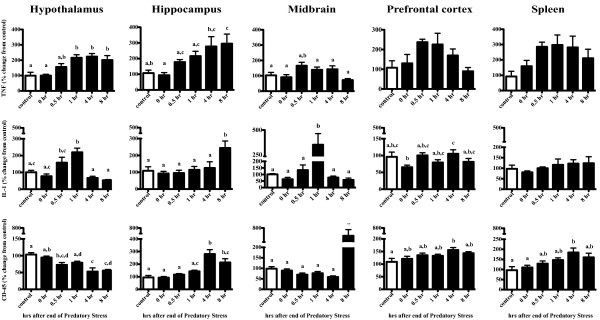
Gene expression analyses indicate increases in Th1 cytokines and microglia activation in multiple brain regions. To determine the extent that acute PS stimulated an inflammatory response, we conducted a time course examination of 4 brain regions and spleen. A one-way ANOVA and Tukey's post hoc revealed that both TNF and IL-1 were increased at respective time points following PS within the hypothalamus, hippocampus, and midbrain. Changes in the microglial activation marker CD45 were also increased within the hippocampus and midbrain, although not until 4 and 8 hrs after cessation, respectively. Changes in the prefrontal cortex and spleen are also provided. Columns that do not share the same letter are significantly different (One-way ANOVA; p < 0.05). Data are expressed as percent change from control and presented as Mean ± SEM. n = 6-8/group.